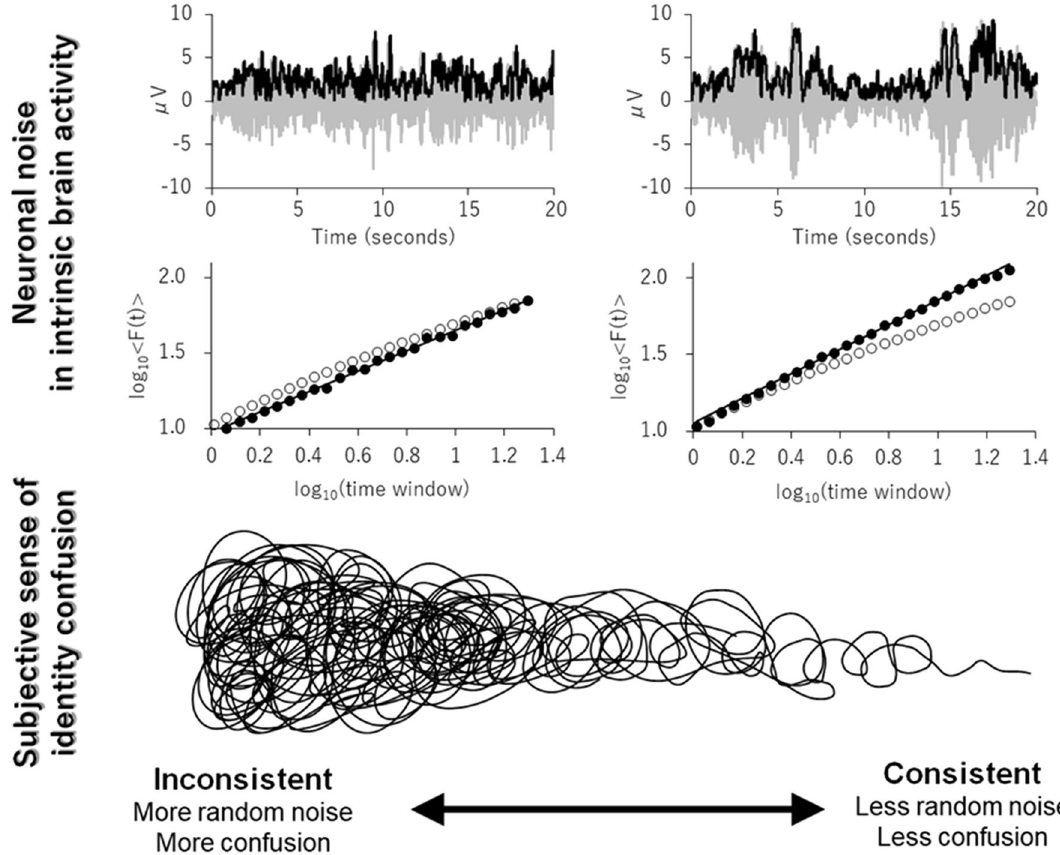
Figure 4. Schematic illustration of the main finding of the present study. The upper row shows examples of the 20 s filtered EEG signal of 8–13 Hz at FCz. The middle row represents the DFAe fluctuation functions. The filled circles represent data, and the open circles, shown as a reference, depict the surrogated data as with Fig. 1. The left panels show data from the participant with DFAe = 0.68 and identity confusion = 25, and the right panels show data from the participant with DFAe = 0.80 and identity confusion = 11. The third row represents a schematic figure of identity